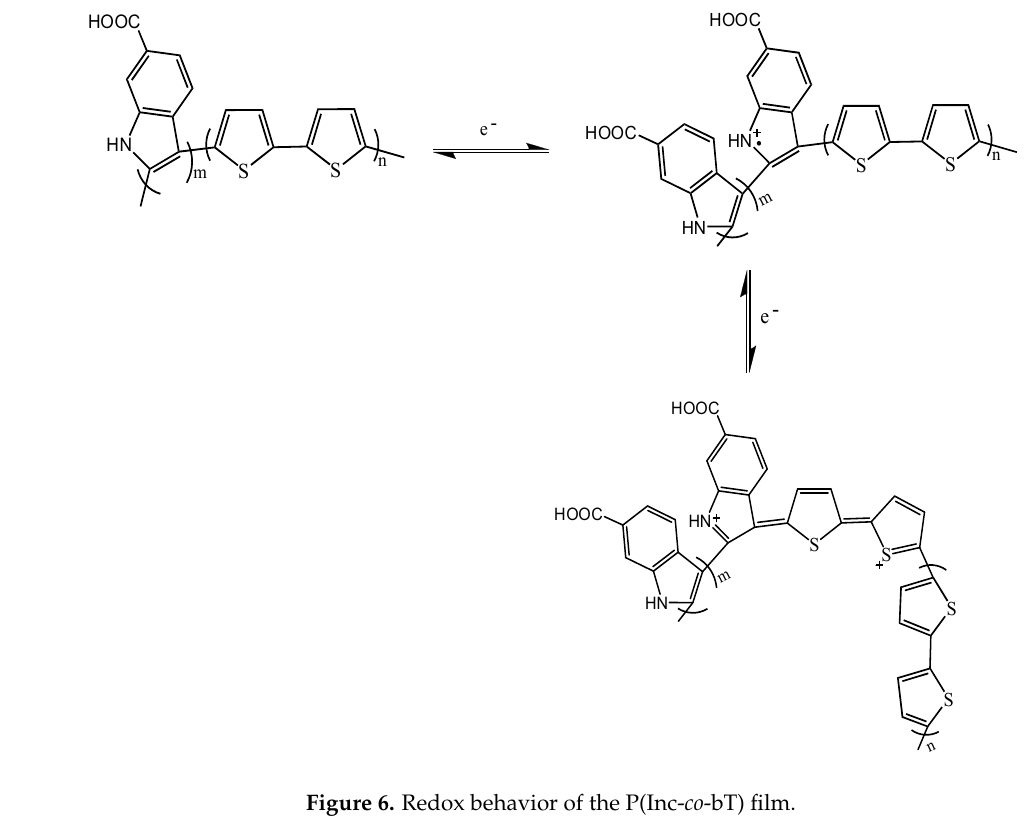
Figure 5. ( a ) CV curves of the P(Inc- co -bT) film at different scan rates between 10 and 200 mV s − 1 in PC+ACN solution containing 0.2 M LiClO 4 ; ( b ) Scan rate dependence of the anodic and cathodic peak current densities of P(Inc- co -bT) film.